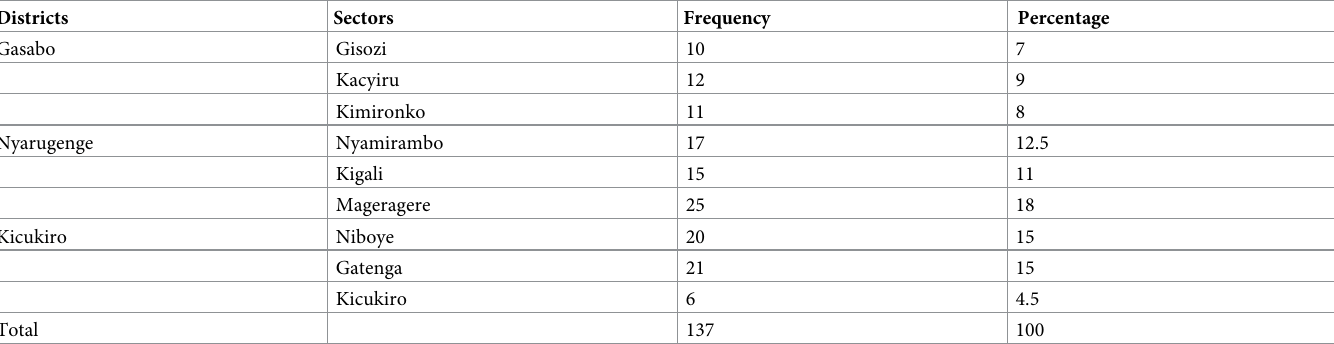
Table 1. Distribution of the sample of households across selected administrative sectors and districts in Kigali city, Rwanda.